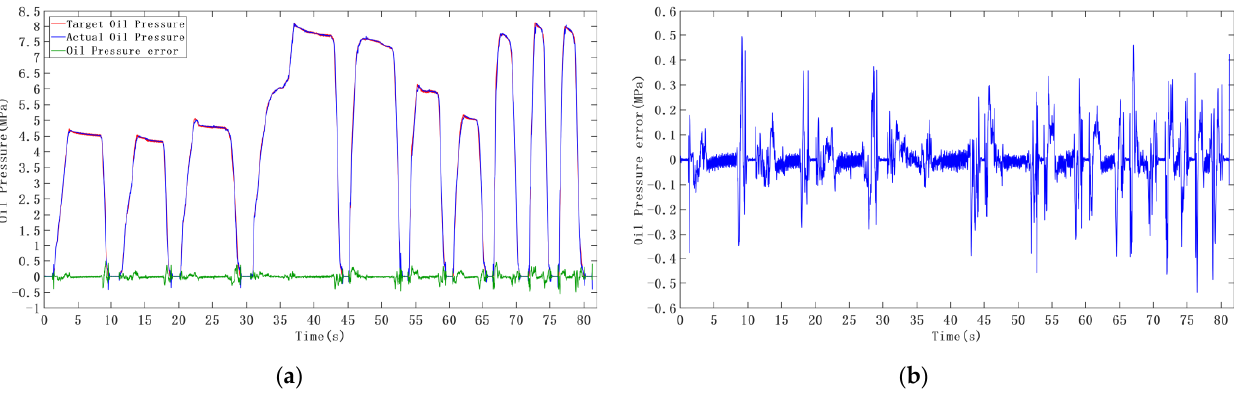
Figure 23. Results of oil pressure following control based on fuzzy PID controller under general braking conditions: ( a ) Target oil pressure, actual oil pressure and oil pressure error. ( b ) Oil pres- sure error.